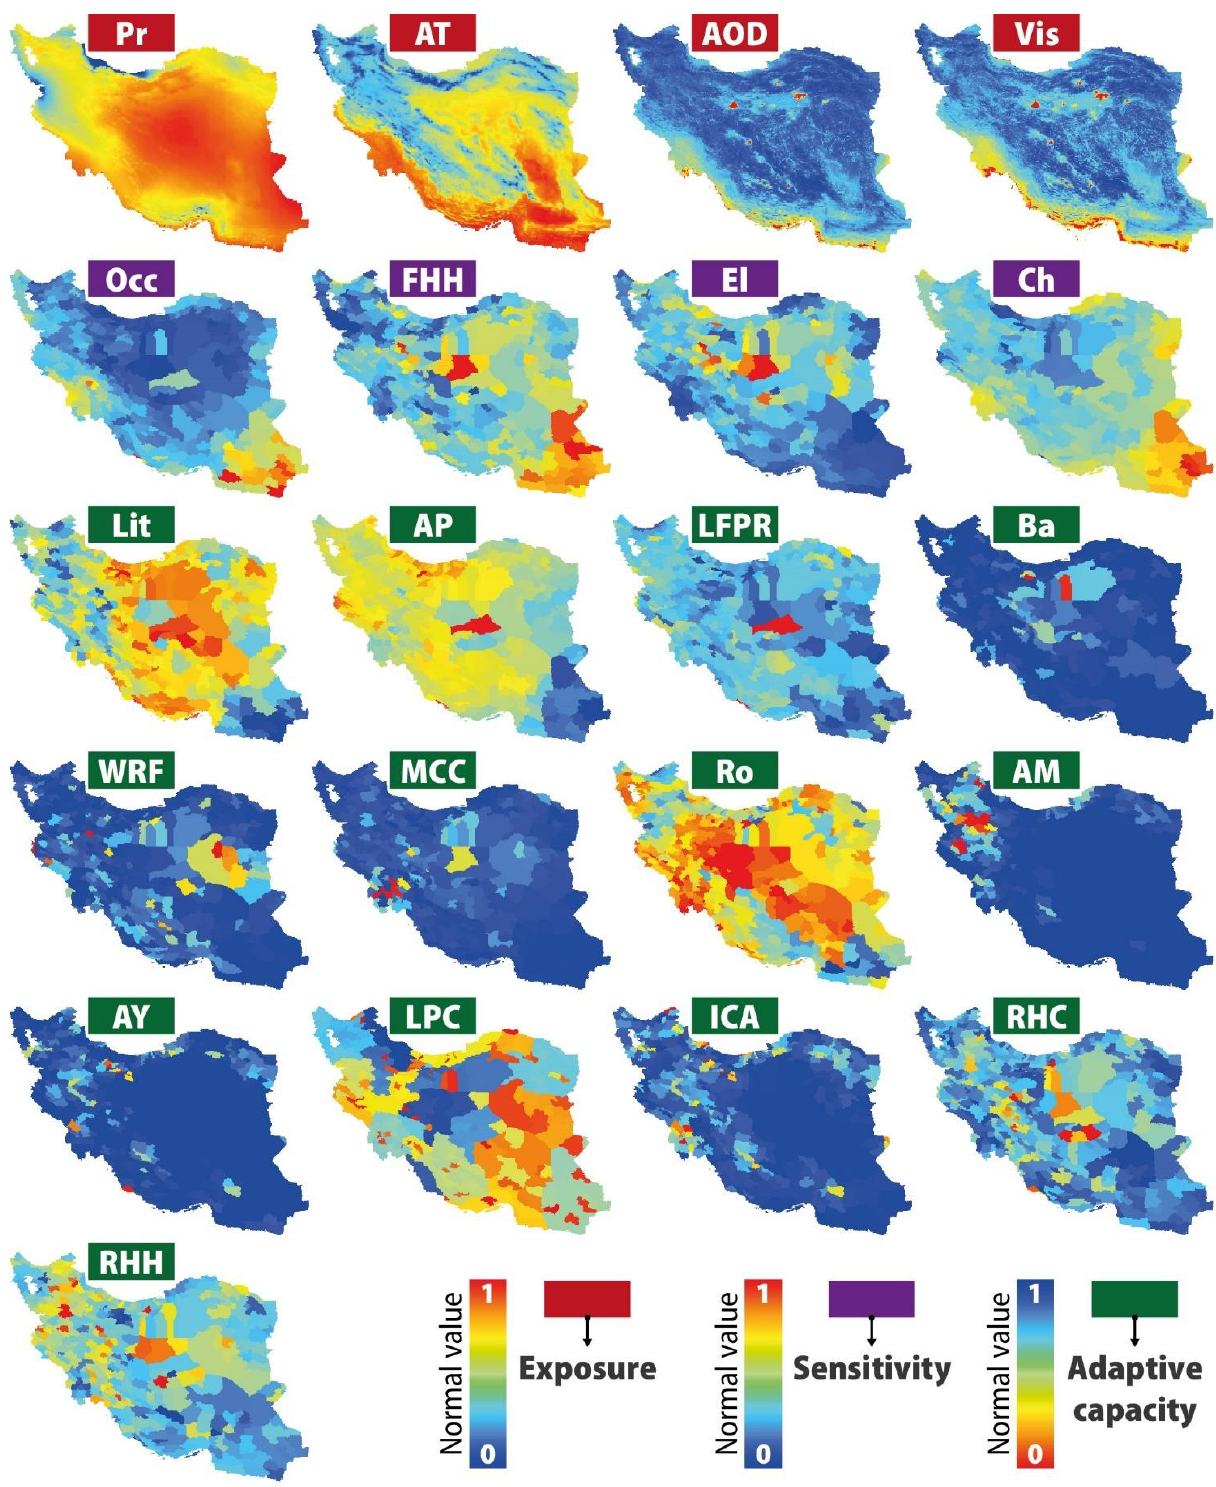
Figure 3. Normalized indicators of exposure, sensitivity, and adaptive capacity components for rural vulnerability assessment to sand and dust storm. See Table 1 for acronyms.